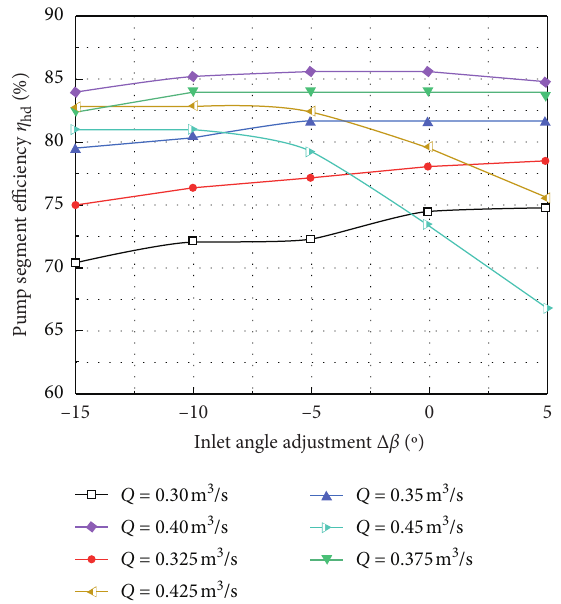
Figure 9: η bd ∼ Δ β curves for different discharge rates when h � 0 . 25 H .